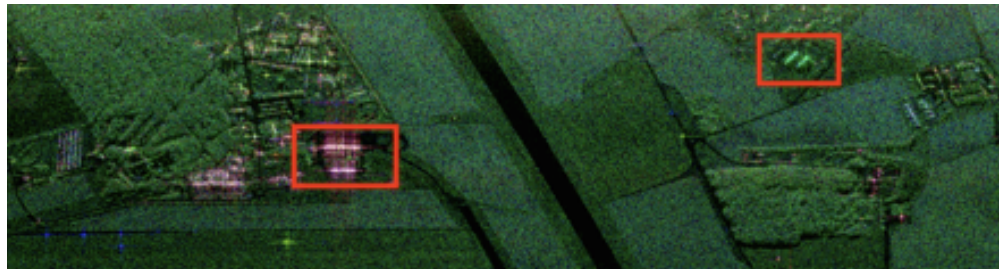
Figure 4. PolSAR image of the former Air Force Base of Bretigny acquired by ONERA (RAMSES, X-band) in the Pauli basis. The sensor trajectory is parallel to the top of the figure. Red rectangles refer to selected areas.